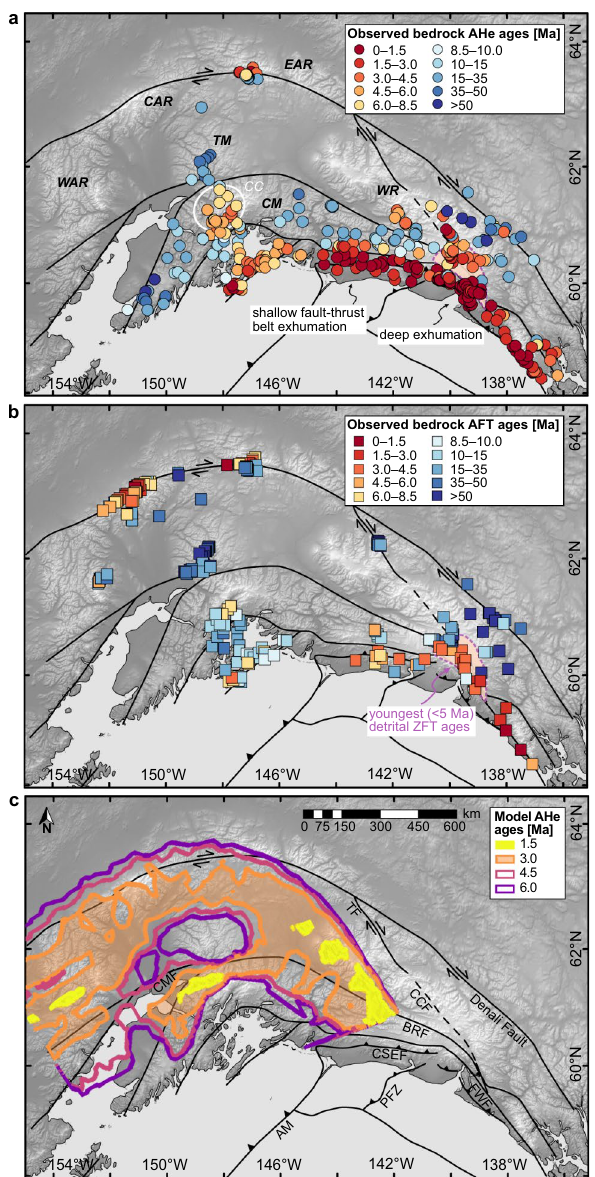
Figure 7. Comparison of observed and modelled spatial distributions of thermochronological ages overlaid on the topography of southeast Alaska and shown with major faults 35,36 . ( a – b ) Compilation of measured bedrock AHe ( a ) and AFT ( b ) ages in the southern Alaskan plate corner (see Supplementary Table 1 and references therein). Note that the area of most rapid and deep exhumation (marked by the pinkish polygon with dashed outline) was observed from detrital zircon fission track (ZFT) data from glacial outwash, i.e., from catchment elevations including low, ice-covered elevations where bedrock cannot be sampled directly (see refs. 18,43,52 for details). Importantly, the very young AHe ages along the area referred to as “shallow fault-thrust belt exhumation” in panel “a” are the result of exhumation along the shallow particle paths in the fold-and- thrust belt 32 in combination with high precipitation on the coast and therefore should not be considered for comparison with the model data. CAR—Central Alaska Range, CM—Chugach Mountains, EAR—Eastern Alaska Range, TM—Talkeetna Mountains, WAR—Western Alaska Range, WR—Wrangell Mountains. White ellipse: CC—Chugach Core. ( c ) Predicted AHe ages for model 4 (fluvial erosion; half upper plate advance). Note that three observed zones of relatively young thermochronological ages (the Fairweather fault/St. Elias syntaxis, the Chugach Core, and the Alaska Range) find their modelled equivalent in the similar relative positions of isolated regions above the main structures of localized deformation in the crust and mantle of the overriding lithosphere (from east to west: transform fault, decollement, and orogenic wedge; see Fig. 3b). The westernmost zone of young predicted ages (associated with the orogenic wedge) does not exactly match the Alaska Range, where there is insufficient measured data for a good comparison. AM—Aleutian megathrust, BRF—Border Ranges fault, CCF—Connector fault, CMF—Castle Mountain fault, CSEF—Chugach-St. Elias fault, FWF— Fairweather fault, PFZ—Pamplona fault zone, TF—Totschunda